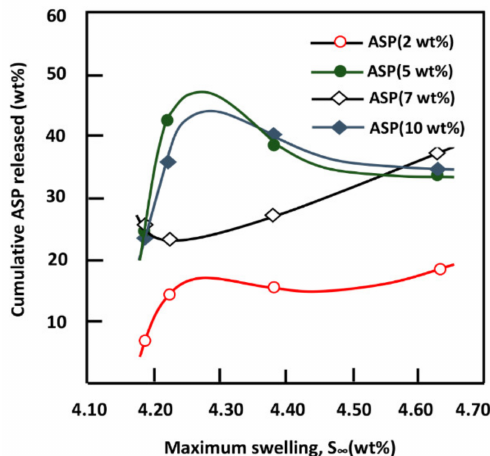
Figure 14. Variation of the cumulative ASP released from ASP/PE- co -VAL/P δ -VL50 drug carrier systems versus the swelling degree during a period of 48 h.